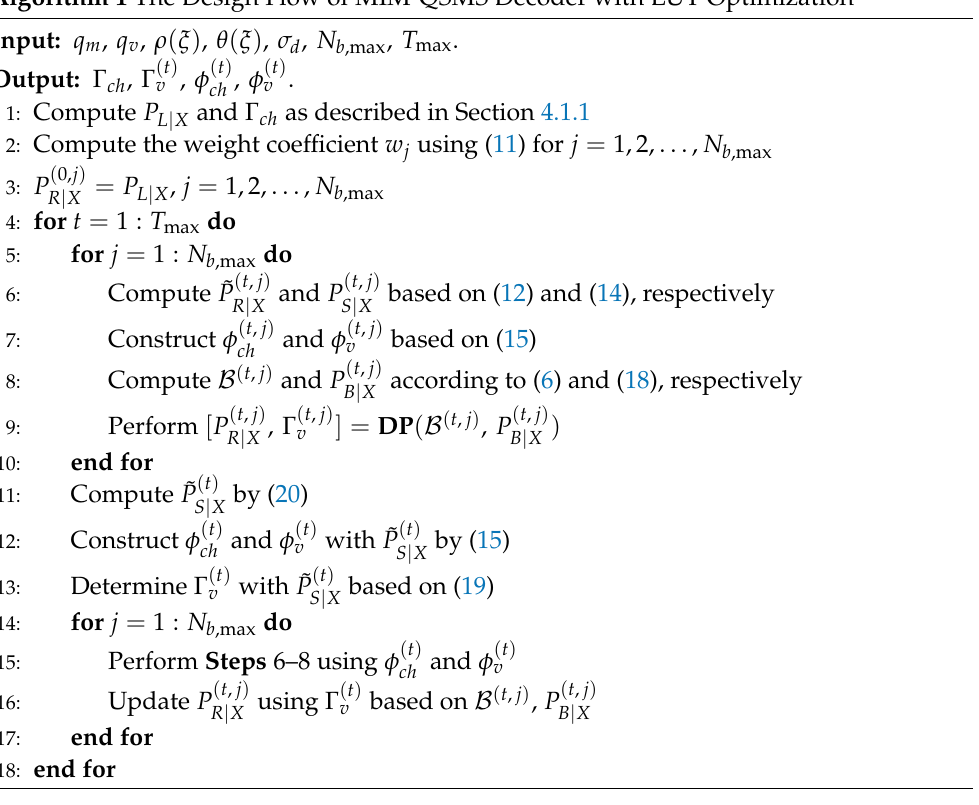
Algorithm 1 The Design Flow of MIM-QSMS Decoder with LUT